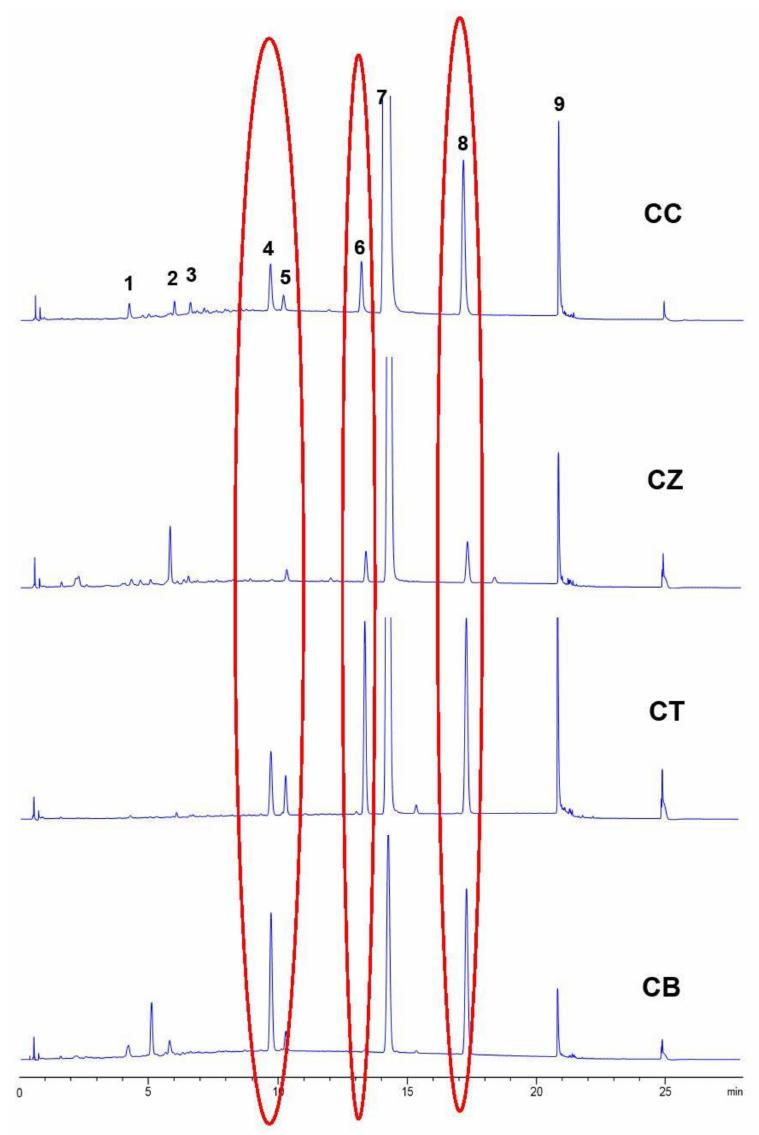
Figure 7. Visual classification for UPLC chromatograms of CC (Cinnamomi cortex) and its adulterants (CZ: Cinnamomum zeylanicum , CT: Cassia Twig , CB: Cinnamomum burmanni